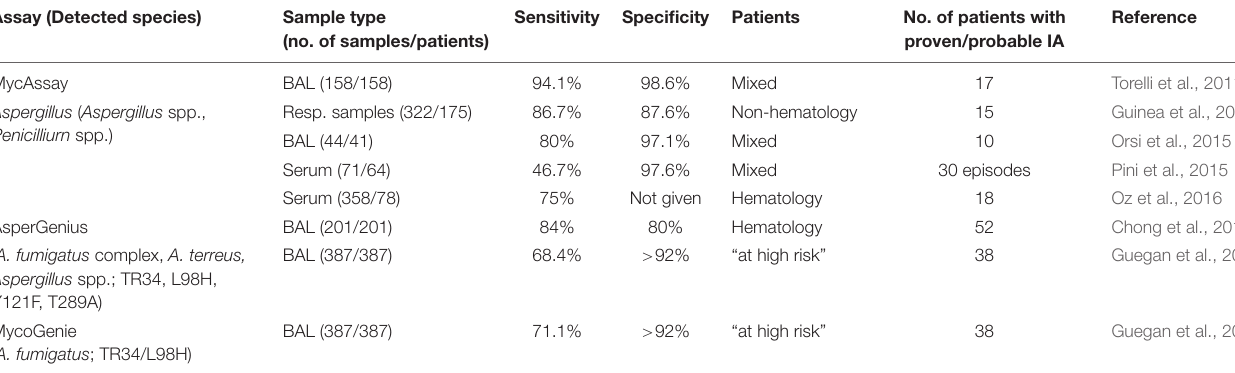
TABLE 1 | Overview of published prospective studies on commercial available PCR assays for Aspergillus detection. Assay (Detected species) Sample type Sensitivity Specificity (no. of samples/patients)